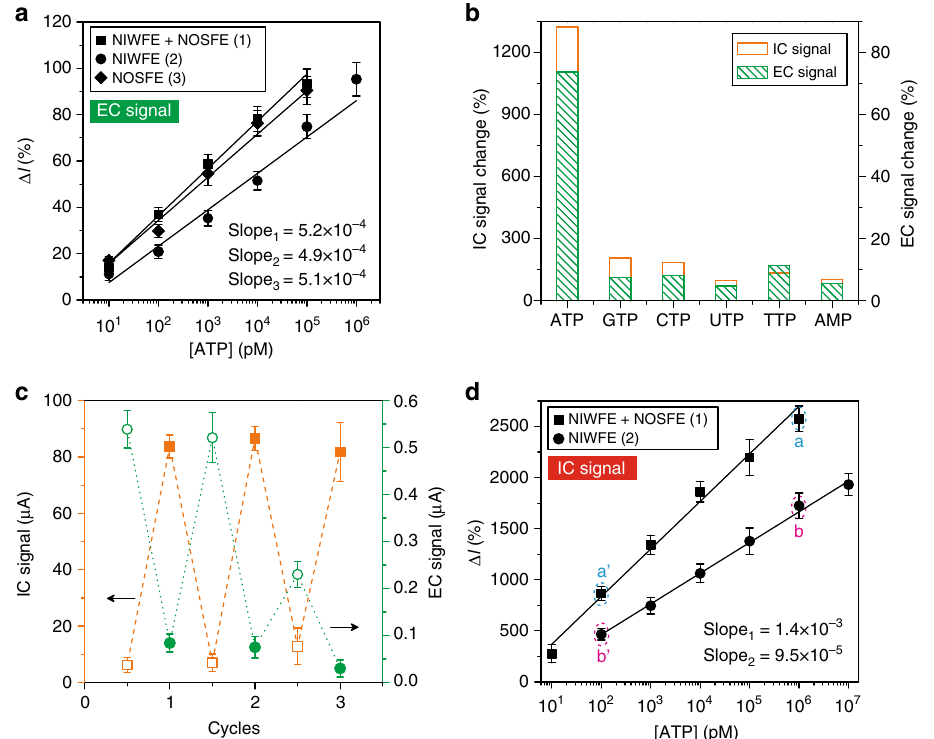
Fig. 4 Dynamic, tunable, and reliable ion-gating behaviors. a Dynamic response of EC signals of the regionally constructed ATP molecular switches. b Speci fi city for ATP recognition and response. The developed biomimetic nanochannels with dual-current protocols were capable of differentiating other ATP analogs. In this case, 0.1 μ M ATP and 100 μ M other potential interferents were used. c Retrieval of molecular switch and ion-gating functions by repeatedly investigating assembly (hollow symbols) and disassembly (solid symbols) process. d Continuously tunable ion-gating ability of regionally assembled functional elements. The Δ I values notated in dashed circles were 866% (a ′ ), 2577% (a), 469% (b ′ ), and 1725% (b), respectively. Error bars represent standard deviations of independent triple